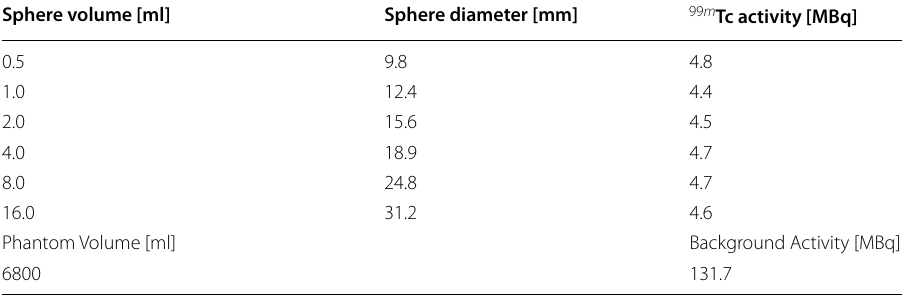
Table 4 The six spheres of the Jaszczack phantom with their respective activity and the background are shown. Each of the value reported in this Table is the mean value of five different measurements, with a standard deviation less than 1%. These errors must be added to the 10% error on the activity as stated by the dose calibrator manufacturer Sphere volume [ml]